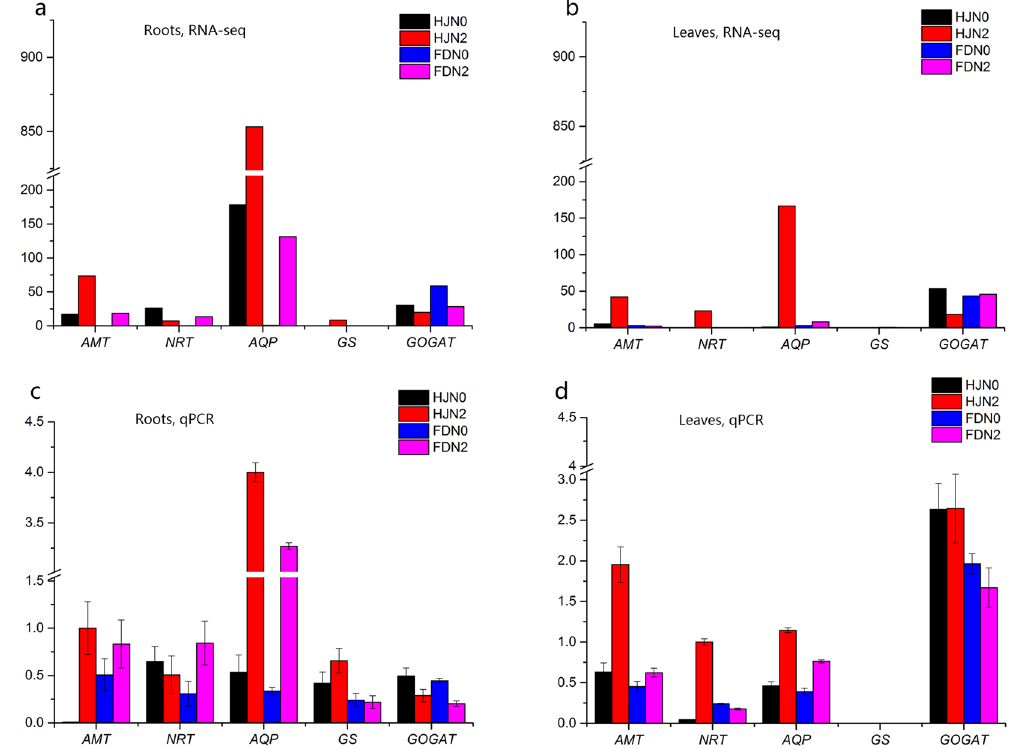
Figure 4. The expression levels of nitrogen associated in Camellia in response to ammonium. ( a ) The expression levels of genes in FPKM in RNA-seq data in the roots. ( b ) The expression levels of genes in FPKM in RNA-seq data in the leaves. ( c ) The relative expression levels of genes in the roots confirmed by RT-qPCR. ( d ) The expression levels of genes in the leaves confirmed by RT-qPCR. “HJN0” “FDN0” represent C . sinensis HJ/FD treated with 0 g of (NH 4 ) 2 SO 4 (the control). “HJN2” “FDN2” represent C . sinensis HJ/FD treated with 22 g of (NH